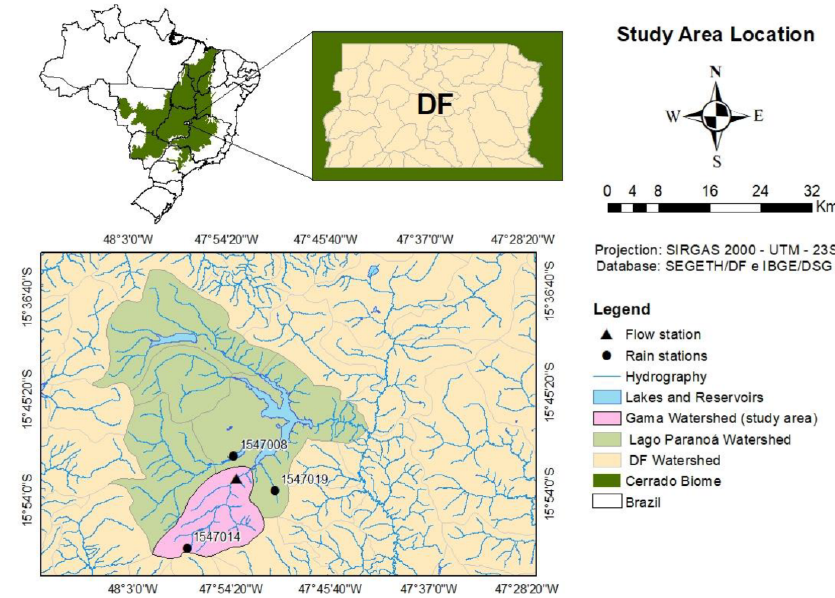
Figure 1. Study area location map.